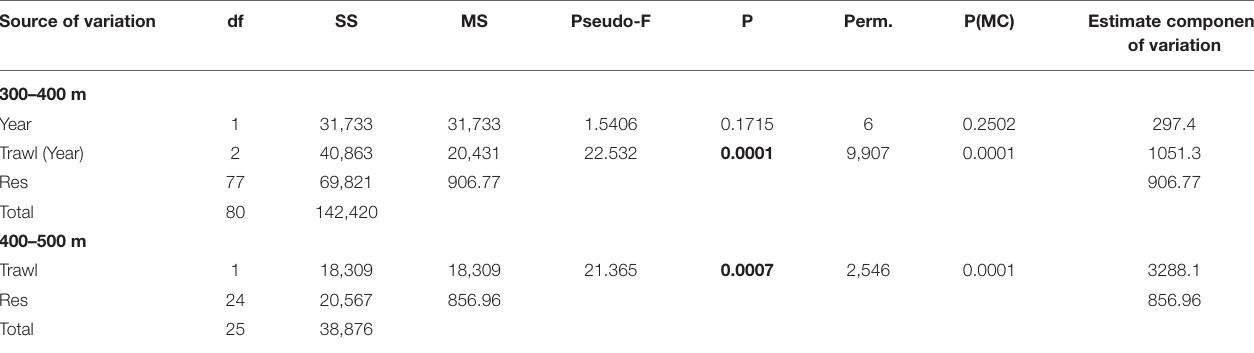
TABLE 4 | PERMANOVA main results based on the mega-epibenthic faunal community composition dataset of the 2-factor nested design [Year and Trawl (Year)] for muddy-sand sediments between 300 and 400m water depths and 1-factor design (Trawl) for depths 400–500m. Source of